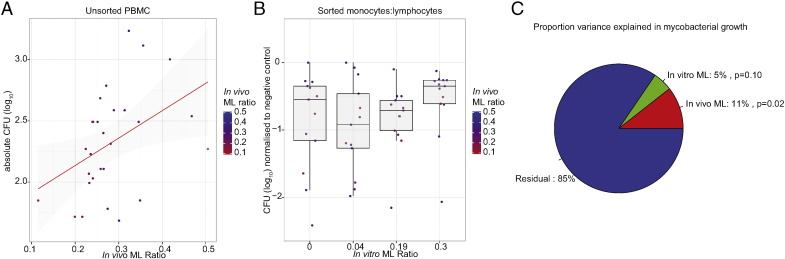
The ML ratio is associated with mycobacterial growth ex vivo, but the in vivo ML ratio of the donor dominates in explaining mycobacterial growth in a growth inhibition assay. (A) In a mycobacterial growth assay in which whole blood from healthy human adult donors (n = 29) was co-cultured with BCG Pasteur for 96 h and mycobacterial growth assessed by liquid culture, the ML ratio is associated with mycobacterial growth. Each donor is indicated by a dot that is coloured according to the in vivo ML ratio. A regression line and 95% CI is shown in red and grey respectively. (B) CD14 + monocytes and lymphocytes sorted from healthy human adult donors (n = 13) were combined in vitro at ratios that approximate the 25th (0.04), 50th (0.19) and 75th (0.30) centiles of the background population and cultured with BCG Pasteur for 72 h and mycobacterial growth assessed by liquid culture. Lymphocytes alone were added to the control tube (denoted as ML ratio = 0). Each donor is indicated by a dot that is coloured according to the in vivo ML ratio. Boxes denote the 25th, 50th and 75th centiles and whiskers extend to median ± 1.5 ∗ IQR. (C) In a multivariate linear regression model of data from part B, the in vivo ML ratio significantly explains 11% of the variance in mycobacterial growth whilst the in vitro ratio explains 5% of variance, albeit not statistically significant.